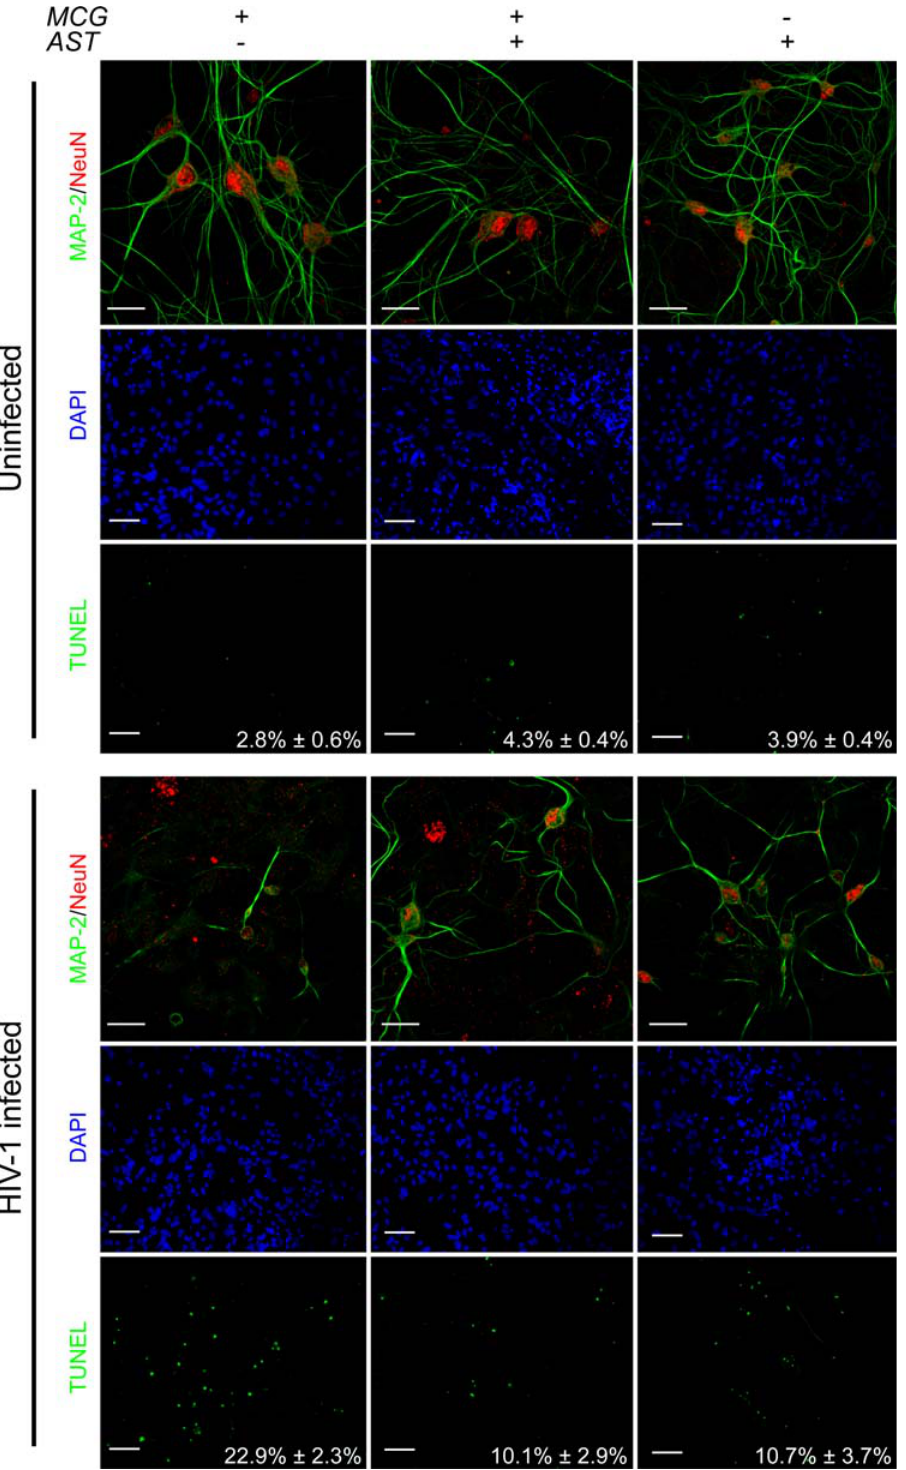
Figure 1. Neurotoxic activities of culture fluids from HIV-1/VSV infected microglia attenuated by microglia-astrocyte co-cultivation. Mouse neurons were cultured for 10 d and exposed to the 20% conditioned media (CM) from uninfected or HIV-1/VSV infected microglia and/or astrocytes for 24 h. MAP-2 (green) and NeuN (red) expression by neurons was visualized by immunohistochemical staining. Characteristic neurotoxicity, including released nuclear materials and broken neurites, were observed in neurons treated with CM from HIV-1/VSV infected microglia alone. Percentages of apoptotic neurons were evaluated by the ratio of TUNEL + (green) neurons to DAPI + (blue) cells. The results are depicted as a mean percentage of apoptotic cells 6 SEM of three experiments. Significant reduction of percentage of apoptotic cells were observed in HIV-1/VSV infected co-cultures and astrocyte groups, compared with those of neurons cultured in microglial CM alone (n=3 determines/group, p , 0.01, determined by one-way ANOVA analysis and Tukey’s multiple comparison post-hoc tests). Bars for MAP-2/NeuN, 20 m m; bars for DAPI and TUNEL, 50 m m.